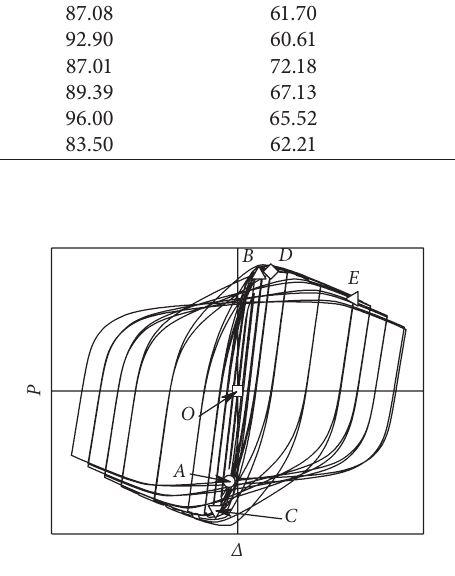
Figure 17: The typical P - Δ curve of specimens of S-CF-CFRP-ST.